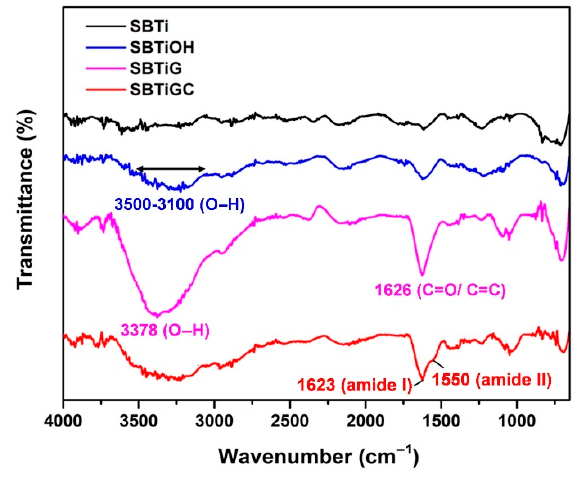
Figure 2. Surface ATR-FTIR spectra of test samples.